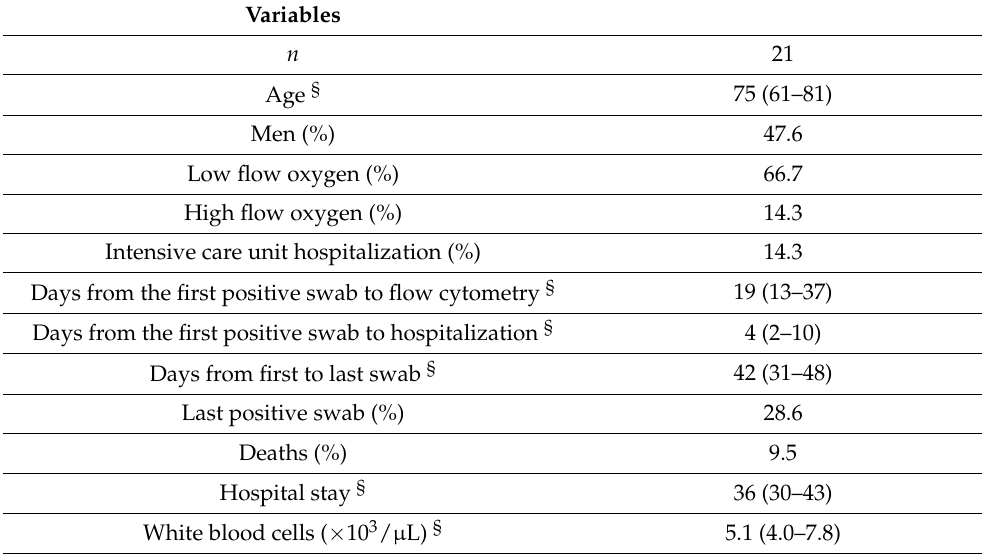
Table 1. Clinical characteristics of the hospitalized COVID-19